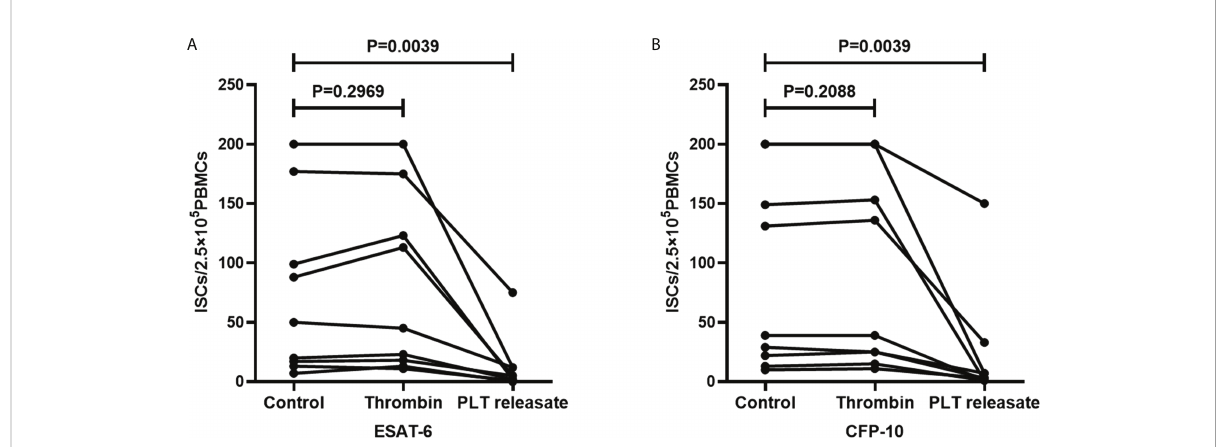
FIGURE 9 The supernatants of thrombin-activated platelets decreased the numbers of ISCs. PBMCs used for T-SOPT assay were resuspended with AIM-V medium, the supernatants of thrombin-activated platelets, or AIM-V medium mixed with thrombin, respectively (n=9). The ISCs of three groups in response to (A) ESAT-6 and (B) CFP-10 were counted and compared by paired Student ’ s